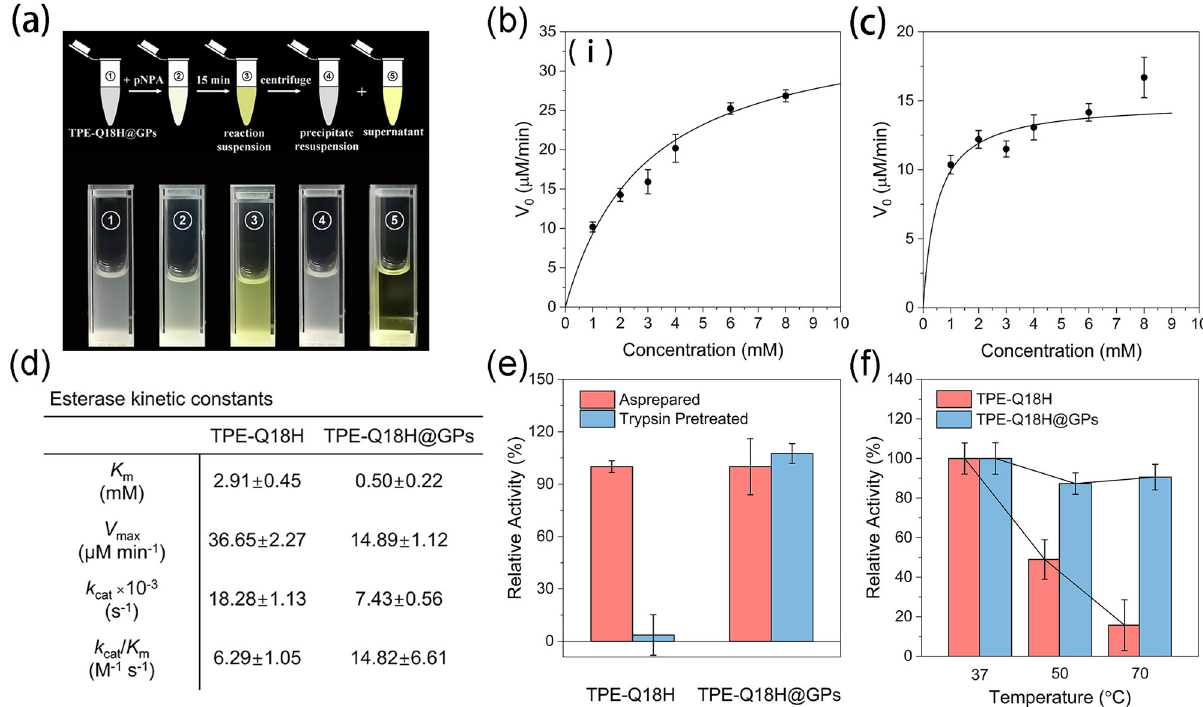
Fig. 5 The ester hydrolysis activity of TPE-Q18H nano fi bers and TPE-Q18H@GPs. a The reaction and separation procedure of product 4-nitrophenol with compartments. Non-linear fi tting of pNPA hydrolysis catalyzed by b TPE-Q18H nano fi bers and c TPE-Q18H@GPs. d Esterase kinetic constants of TPE- Q18H nano fi bers and TPE-Q18H@GPs. e Catalytic activities of TPE-Q18H nano fi bers and TPE-Q18H@GPs after the treatment of trypsin. f Temperature- dependent activities of TPE-Q18H nano fi bers and TPE-Q18H@GPs. Data are presented as the mean ± SD (dot with error bar) of n = 3 independent measurements.